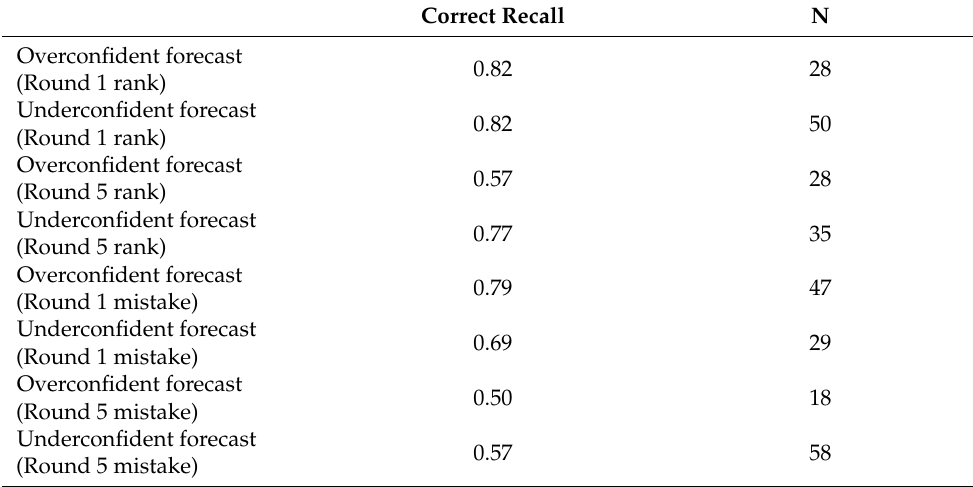
Table 6. Recall on Overconfidence in